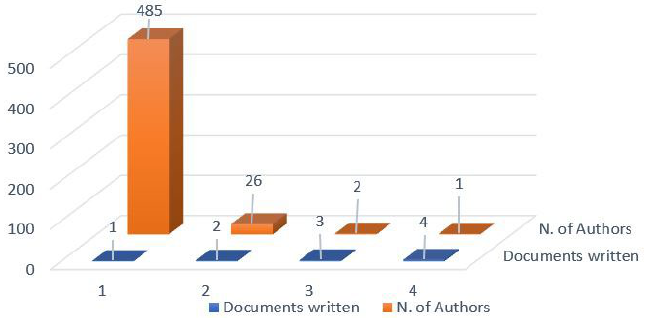
Figure 3. Frequency distribution of scientific productivity 2015–2021.